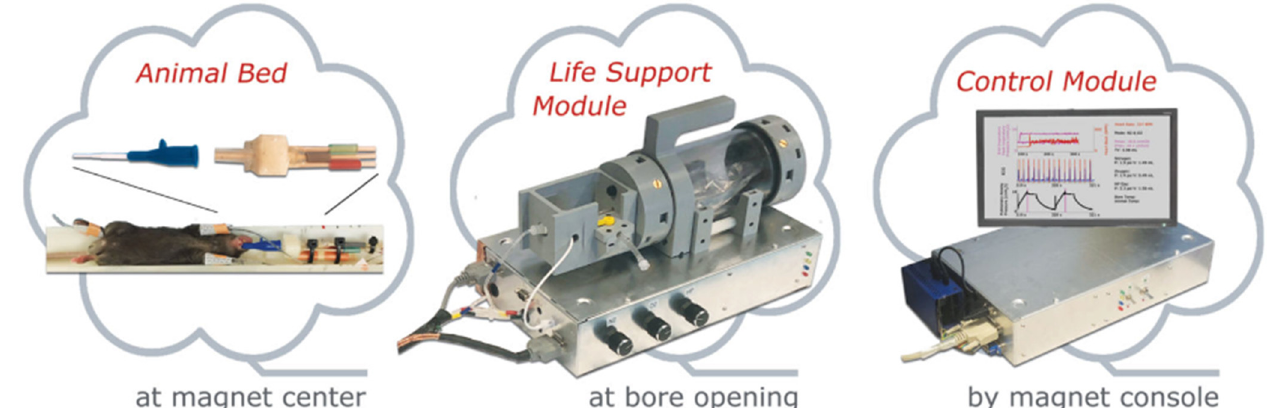
Figure 34. Primary subsystems of an HP gas rodent ventilator. At the magnet center, the rodent lies on the animal bed, connected to physiologic monitoring sensors. The intubated animal (the intubation catheter is magnified) is linked to the life support module, which resides at the entry of the bore and contains the gas-delivery valves, physiologic monitoring circuitry, and HP gas supply. The life support module is connected via a single cable to the control module, which is located next to the MRI user console. Reprinted with permission from Virgincar, et al. ( J Magn Reson 2018, ref. [127]).